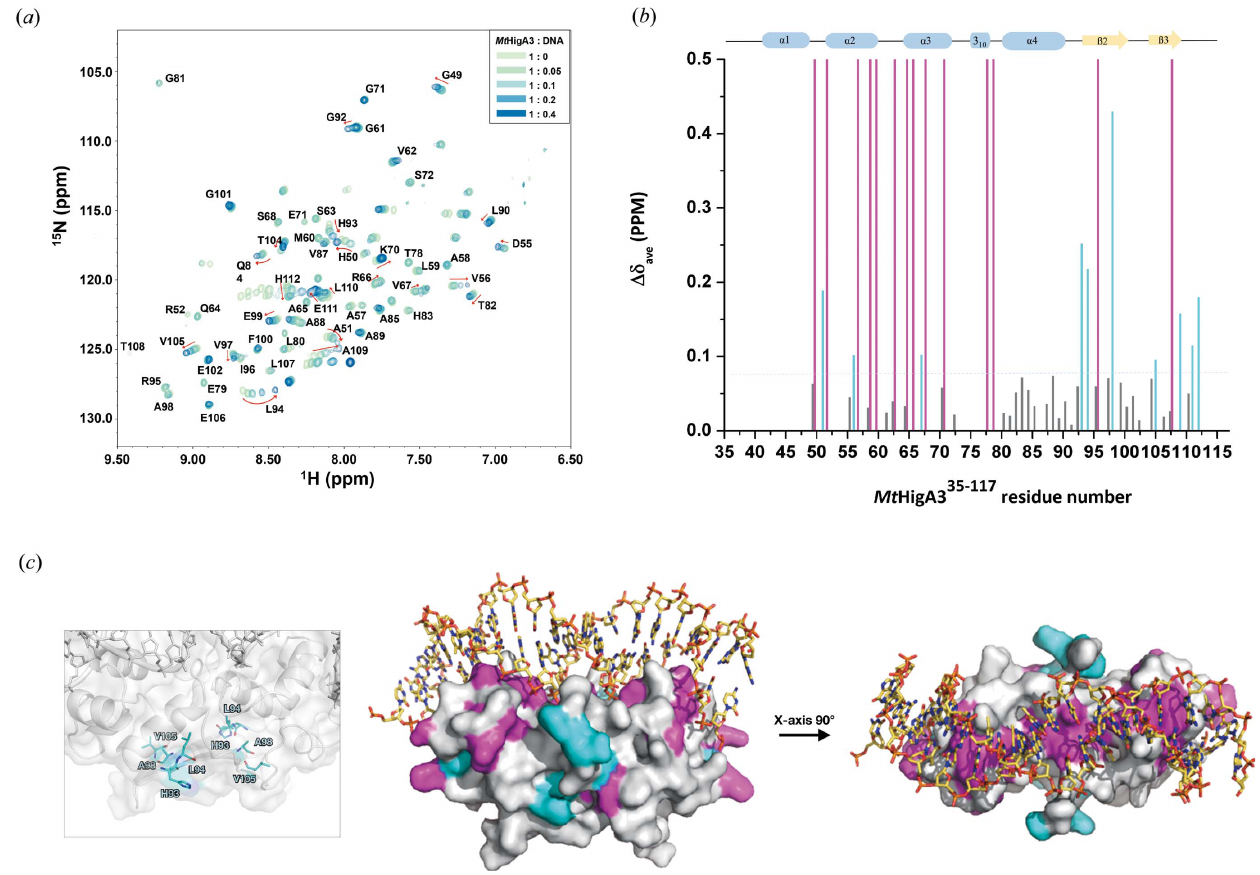
Figure 5 NMR titration of Mt HigA3 35–117 and its promoter DNA. ( a ) Overlaid [ 1 H- 15 N] TROSY–HSQC titration spectra of 0.4 m M 15 N-labelled Mt HigA3 35–117 with increasing concentrations of promoter DNA. ( b ) CSP analysis of Mt HigA3 35–117 upon binding to the promoter DNA. CSPs > average CSP values (0.075) are coloured cyan, CSPs < average CSP values (0.075) are coloured grey, and the peaks that disappeared upon the addition of DNA are presented as magenta bars. Secondary structural elements of Mt HigA3 35–117 are represented above the plot by blue cylinders ( (cid:3) -helices) and yellow arrows ( (cid:2) - strands). ( c ) The residues showing higher CSP values than the average CSP value in the (cid:2) -lid (His93, Leu84, Ala98 and Val105) are shown as sticks and coloured cyan in the box. For a clear display, Mt HigA3 bound to DNA is presented as a cartoon diagram in surface view (left). Chemical shift mapping based on the CSP data from ( b ) on the crystal structure of Mt HigA3 bound to DNA in two orientations rotated by 90 (cid:2) . The DNA structure is represented using sticks for